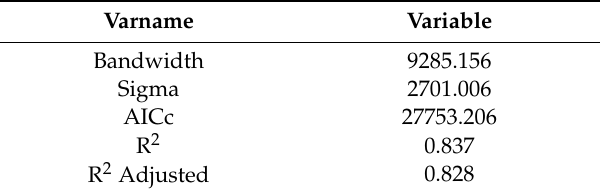
Table 8. Geographically weighted